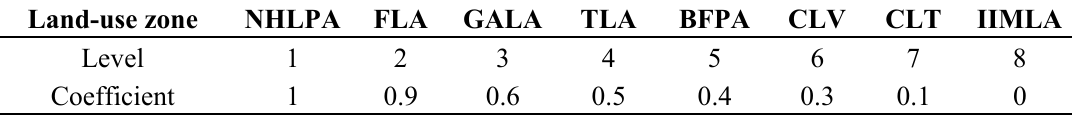
Table 2. The ecological benefit level and coefficients of different land-use